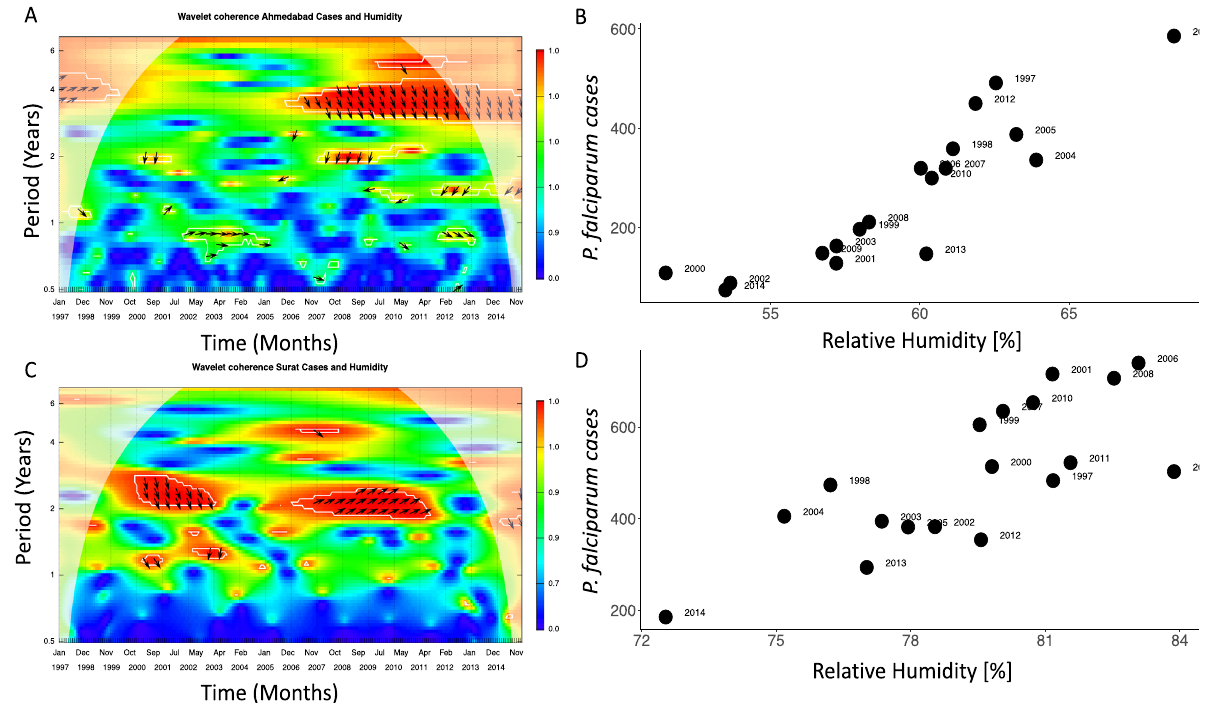
Fig. 1 Temporal association of malaria cases and relative humidity. A – C The cross-coherence wavelet spectrum between humidity and monthly malaria cases in Ahmedabad ( A ) and Surat ( C ). Cross-coherence varies between 0 and 1 in a color scale from blue to red with the lines indicating 5% signi fi cance levels. Only regions within these lines exhibit signi fi cant cross-coherence at those levels. The shaded region corresponds to periods and times that are affected by the boundaries and are outside the so-called cone of signi fi cance. (The RH time series have been previously fi ltered with a low-pass fi lter to remove seasonality and therefore periods below 1 year, and to therefore focus on interannual variability, Fig. S16). B – D The total cases during the transmission season from August to November are shown as a function of average RH in a critical window preceding this season from May to July for Ahmedabad ( B ) and March to July for Surat ( D ). (The corresponding Pearson correlation values are R = 0.72 and 0.69).